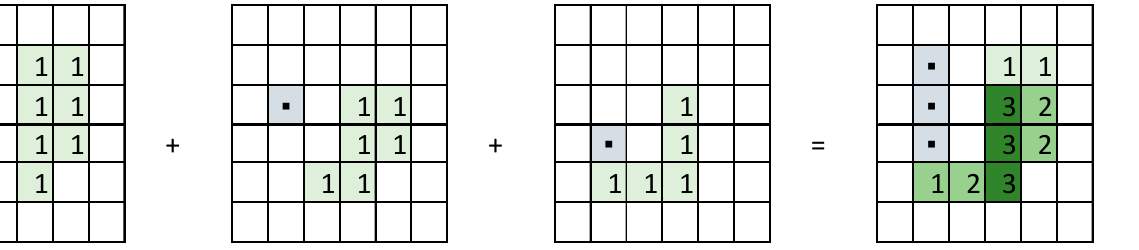
Figure 3. Cumulative viewshed method: numbers in the cell indicates the number of times each cell is visible from the three points in the grey cells.